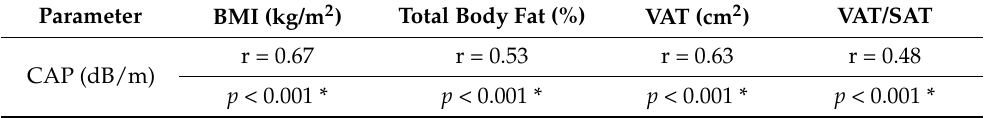
Table 3. Correlations between the CAP and the parameters evaluating adipose